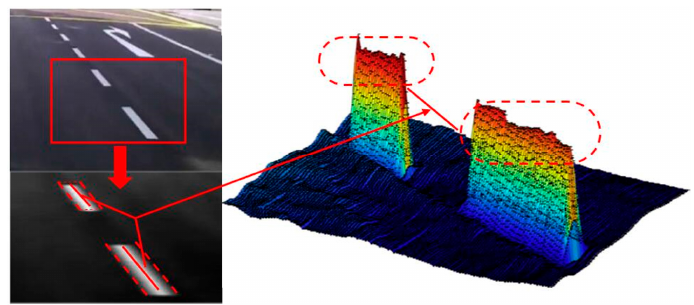
Figure 3. Ridge-feature illustration.